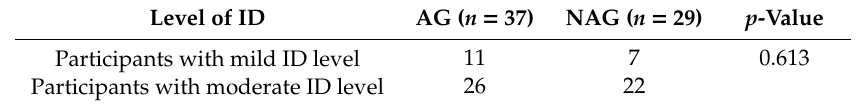
Table 1. Distribution of the participants with intellectual disabilities (ID) over the